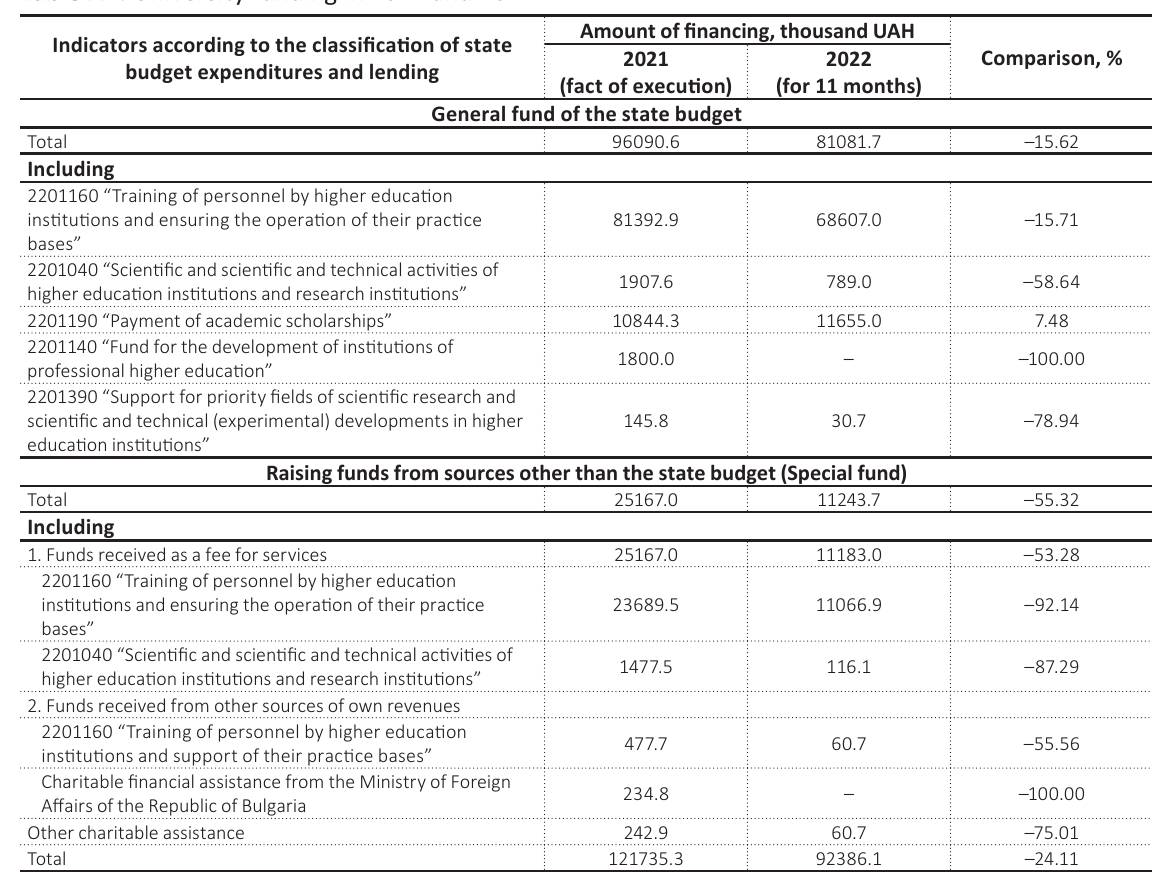
Table A2. University funding in 2021 and 2022 Indicators according to the classification of state